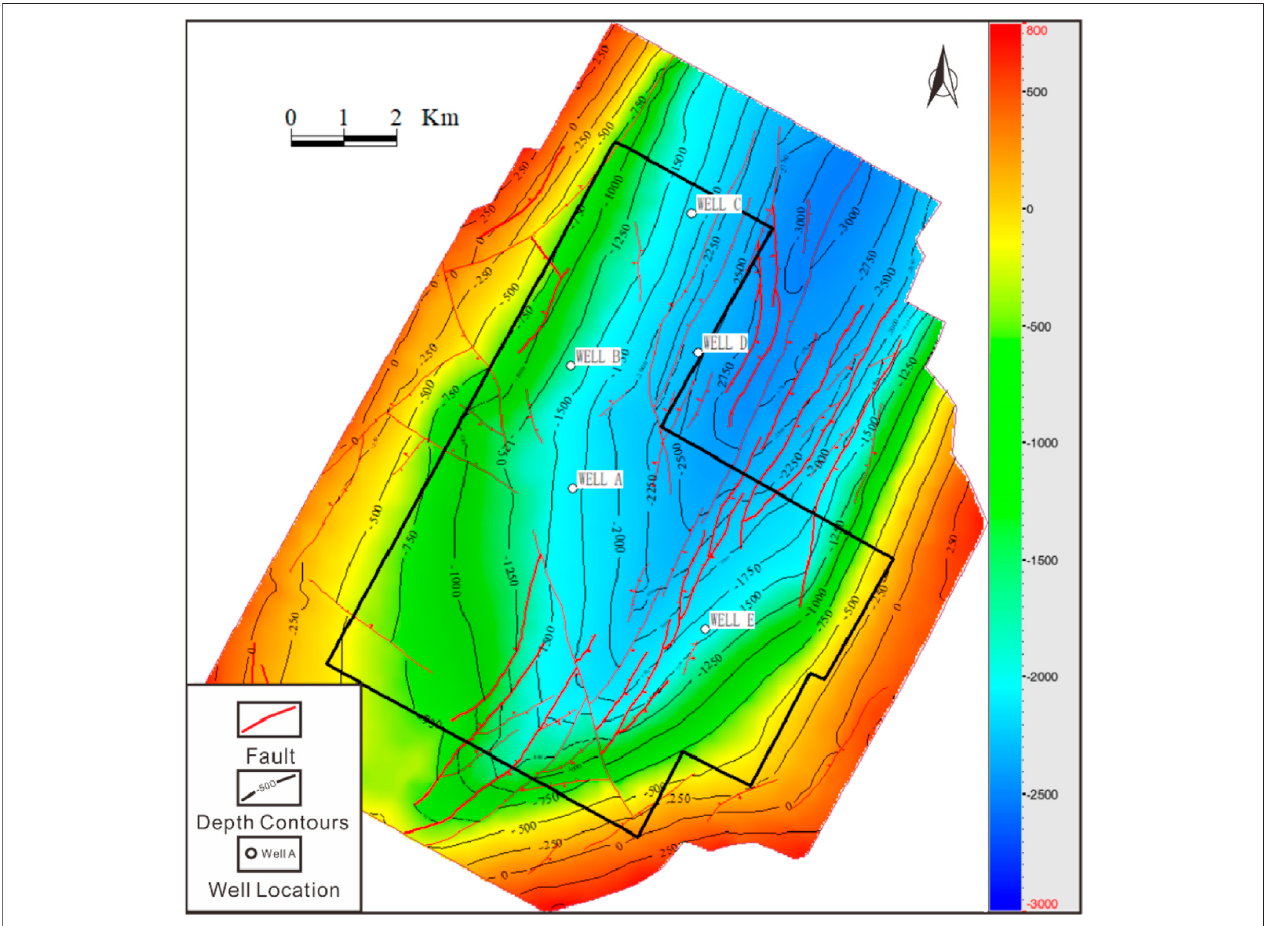
FIGURE 2 | Well locations and main fracture distributions in Anchang